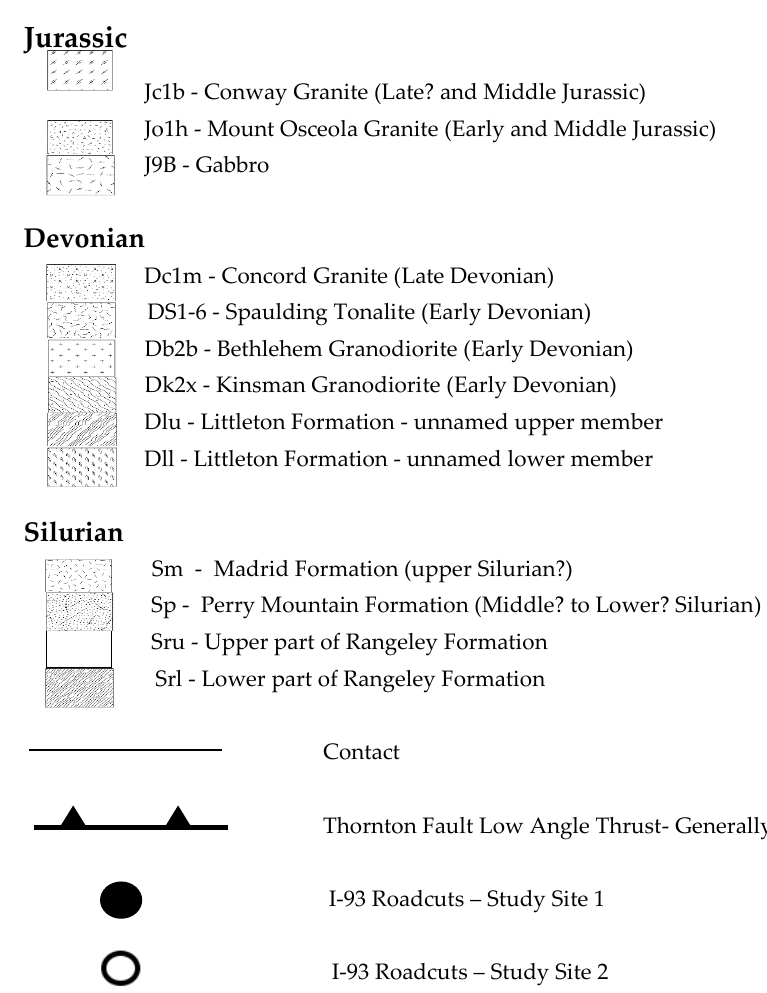
Figure 1. Bedrock geologic map for the area immediately surrounding the two study sites along the I-93 roadcuts in Woodstock, NH, USA. (After [20], sheet 1). Location map is shown in upper left. The study site is located in the Lower Rangeley